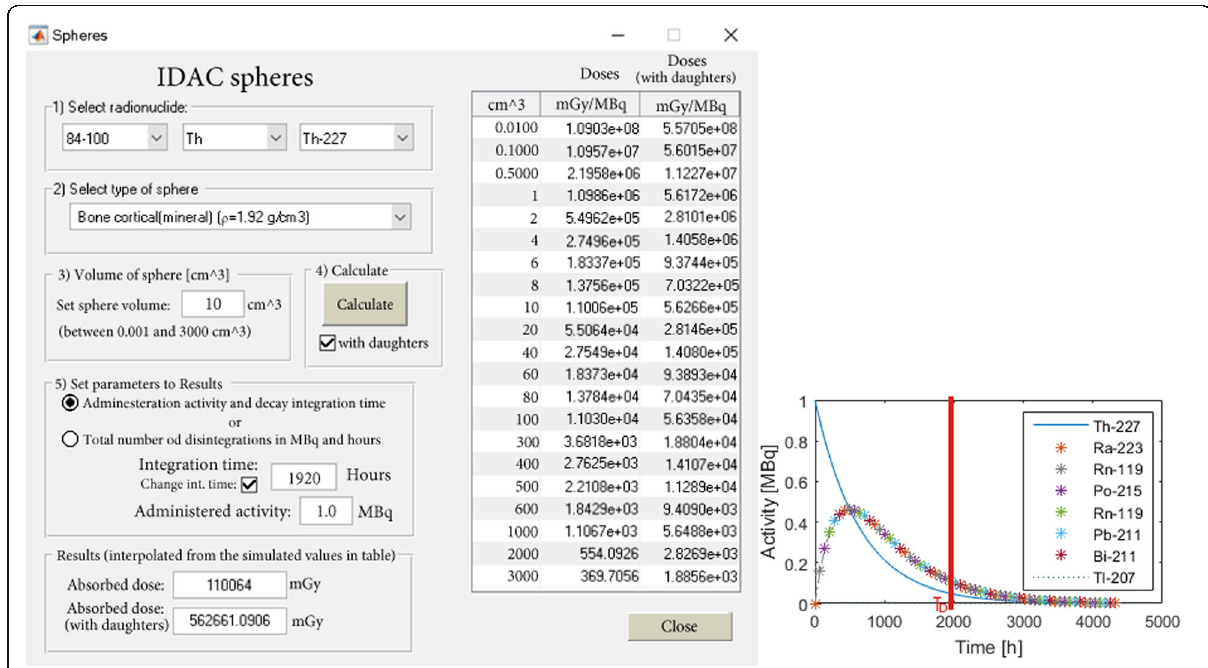
Fig. 3 The module to calculate the absorbed dose to various types of spheres. Left, in this example, a “ bone cortical ” sphere volume of 10 cm 3 was selected. Right, the activity of 227 Th (in MBq). The absorbed dose to the sphere was calculated as 110 Gy (563 Gy including the absorbed dose contribution of daughters) for an administration of 1 MBq 227 Th and an integration period of 80 days ( T D = 1920